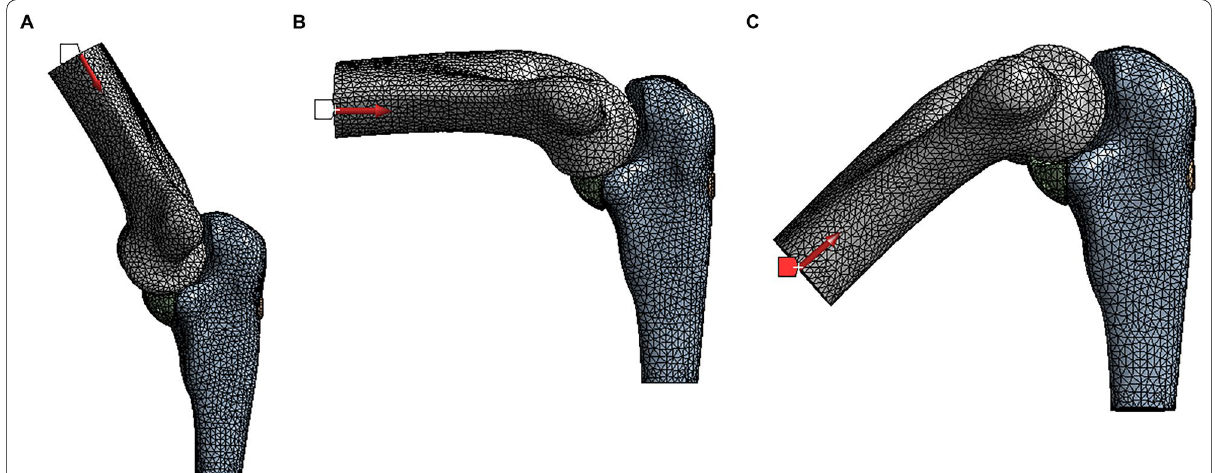
Fig. 3 Loading at various elbow flexion angles. A Loading at 30° elbow flexion. B Loading at 90° elbow flexion. C Loading at 130° elbow flexion. The red arrow indicates the direction of the loading, which is along the axis of the humerus. The triangles represent the fixed